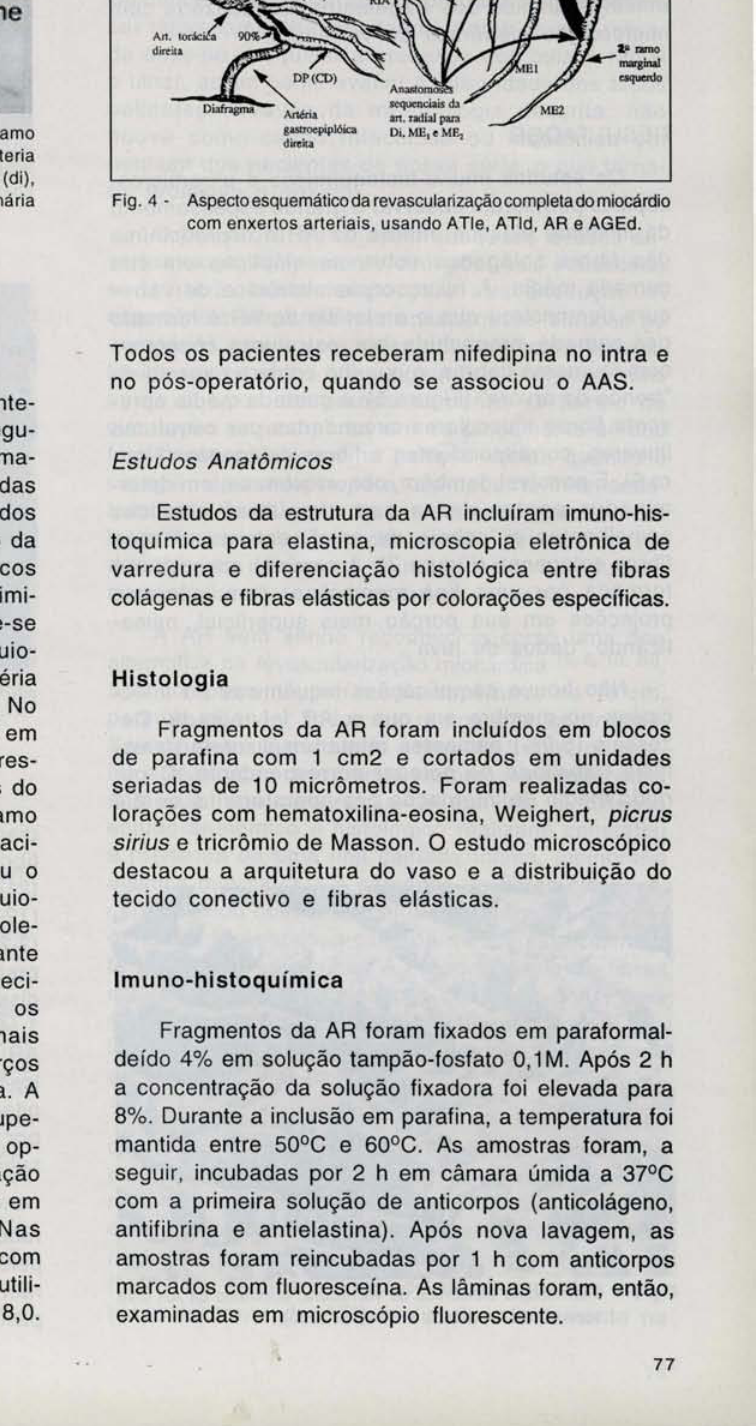
Fig. 4 · Aspecto esquemático da revascularizaçãocompleta do miocárdio com enxertos arteriais, usando ATle, ATld, AR e